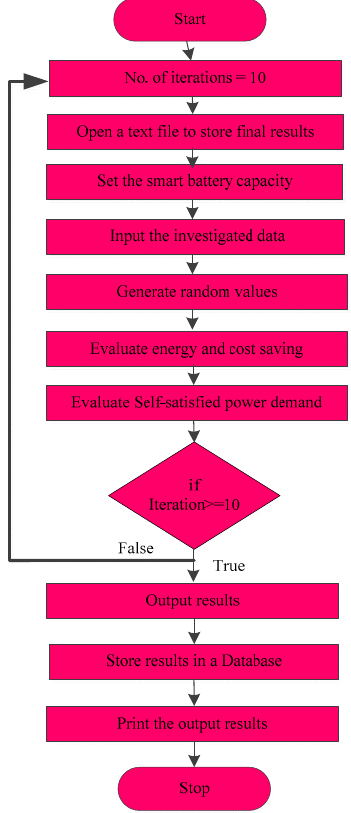
Figure 9. Algorithm